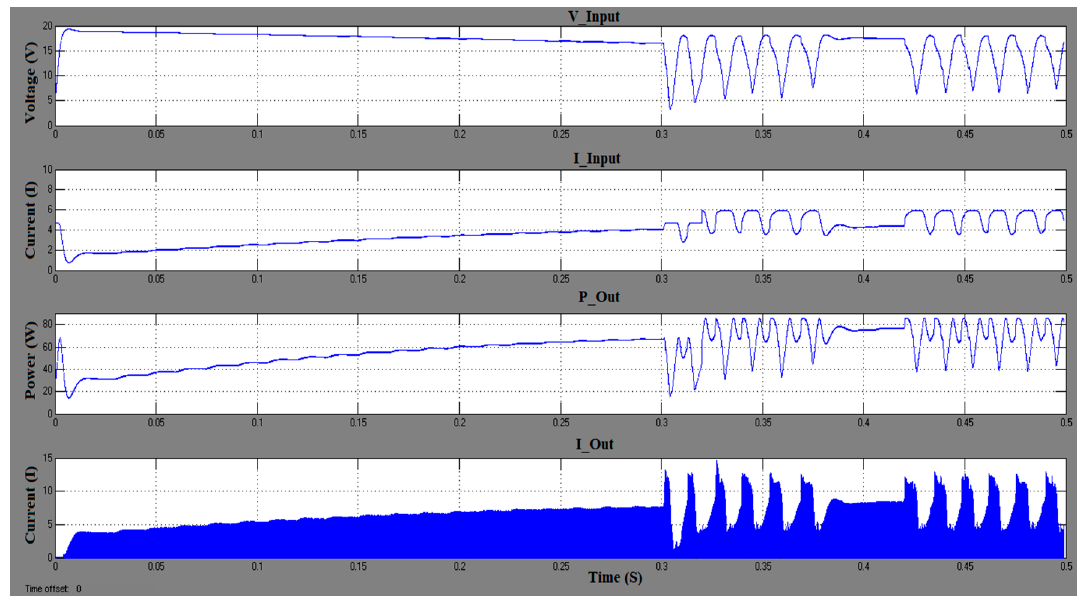
Figure 10. Simulation results of the proposed charge controller.